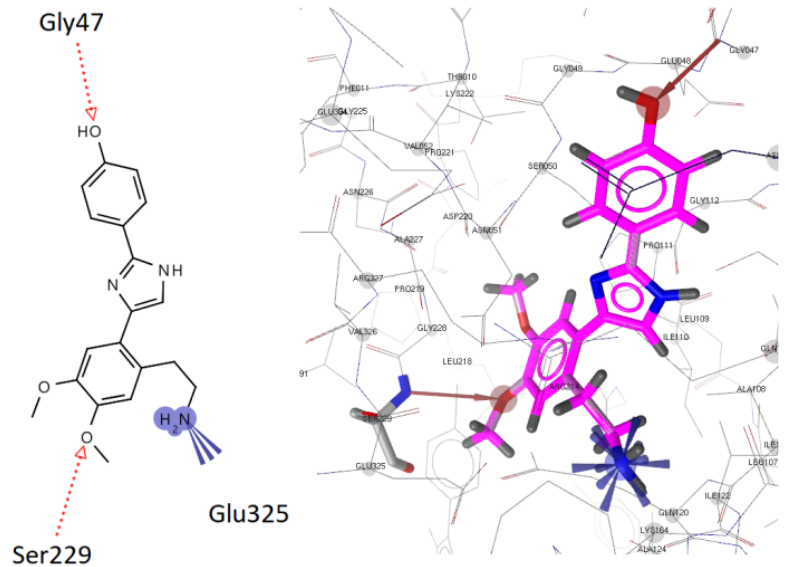
Figure 2. Docked conformation of the most active compound 3 in E. coli MurB. Red dotted arrows indicate H-bond, and blue lines indicate positive ionizable interactions.